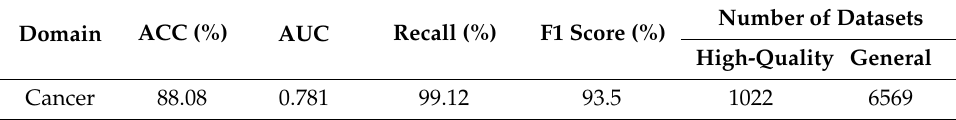
Table 6. The result of evaluating performance of the proposed model on test dataset collected through queries for a di ff erent domain (i.e.,